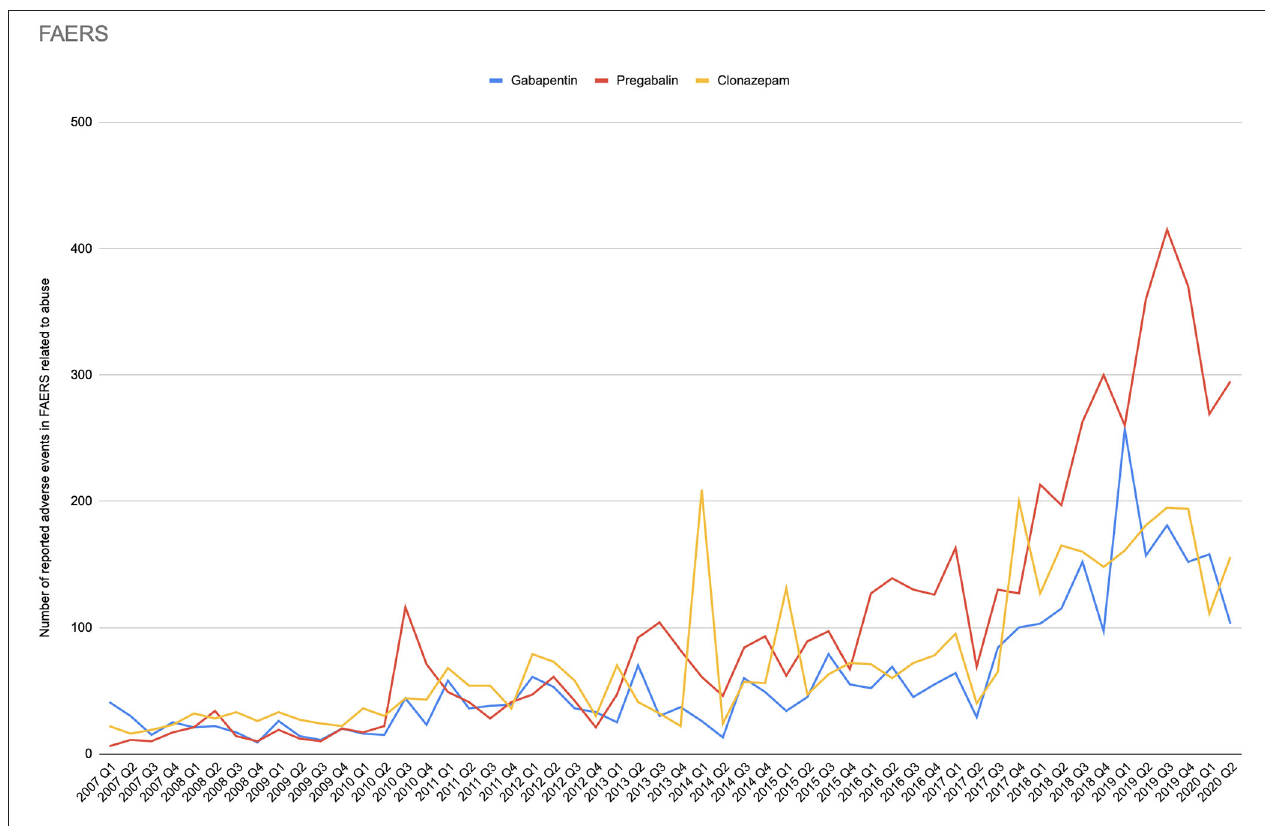
FIGURE 3 | Number of reported adverse events in the FAERS database related to abuse.